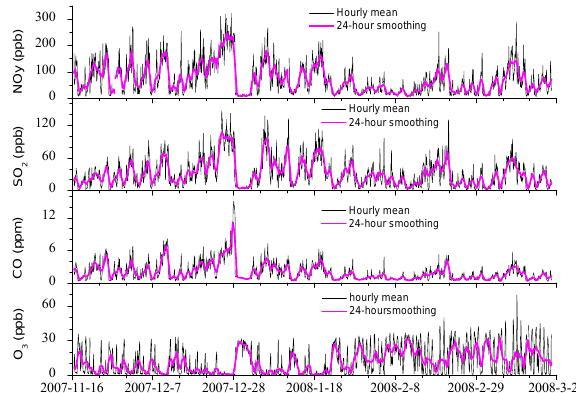
Fig. 3 The time series of hourly average O 3 , NO y , SO 2 , and CO concentrations during the Fig. 3. The time series of hourly average O 3 , NO y , SO 2 , and CO observation period at CMA. The 24-hour moving averages are also shown to make the concentrations during the observation period at CMA. The 24-h general trends clearer. moving averages are also shown to make the general trends